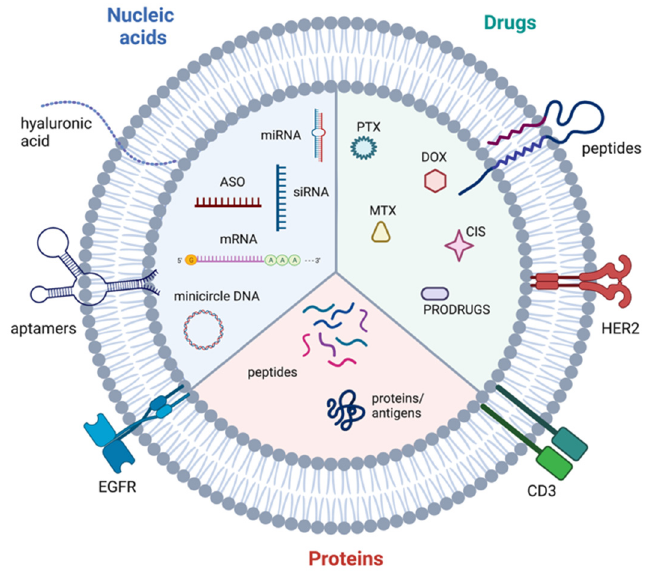
Figure 6. EVs as delivery vehicles. Therapeutic nucleic acids, including DNAs, RNAs and antisense oligonucleotides (ASO), chemotherapeutic drugs, including doxorubicin (DOX), paclitaxel (PTX), cisplatin (CIS) and methotrexate (MTX), along with peptides and proteins can be loaded into EVs. EVs can also be functionalised with proteins presenting targeting abilities and/or anti-tumour effects. Table 3. List of main extracellular vesicles used as delivery vehicles for therapeutic agents.